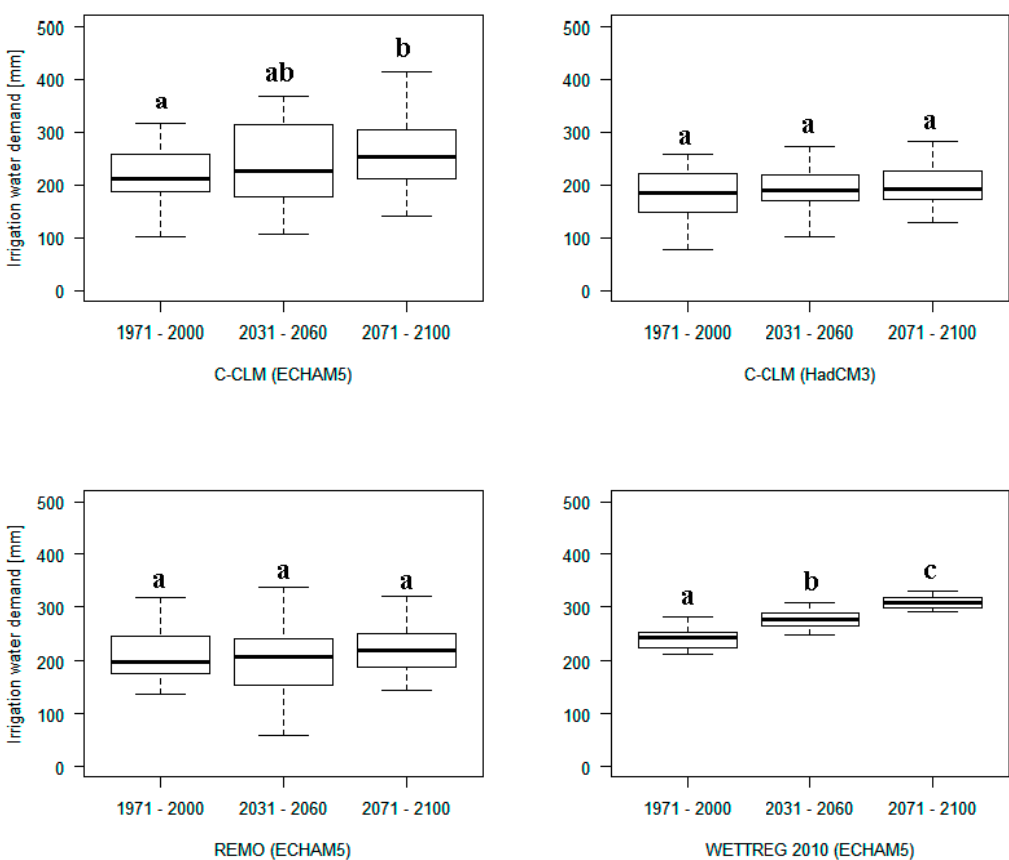
Figure 5. RCM simulated onion specific Irrigation water demand, IWD total , in mm during onion cultivation period in 1971–2000, 2031–2060 and 2071–2100. Significant differences between the 30-year periods are labelled with different letters (ANOVA, Tukey, Kruskal-Wallis, post-hoc HSD Test, alpha = 5%).